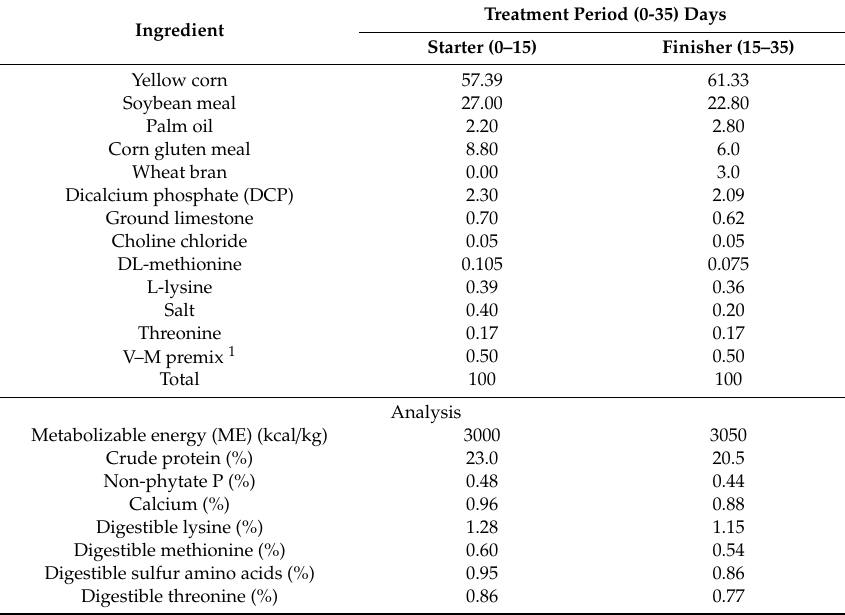
Table 1. Composition of starter and finisher